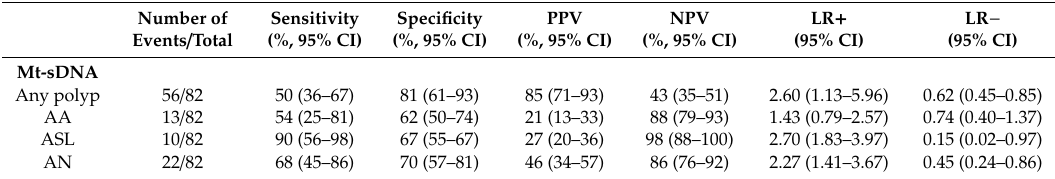
Table 3. Performance of multi-target stool DNA test (mt-sDNA).